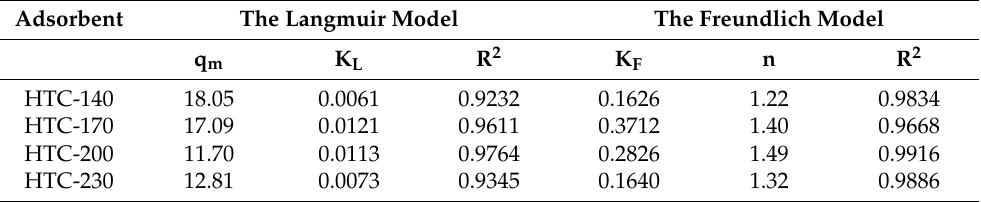
Figure 9. Sorption isotherms of Cd 2+ by hydrochar. Table 3. Parameters of adsorption isotherm model for Cd 2+ adsorption hydrochar.